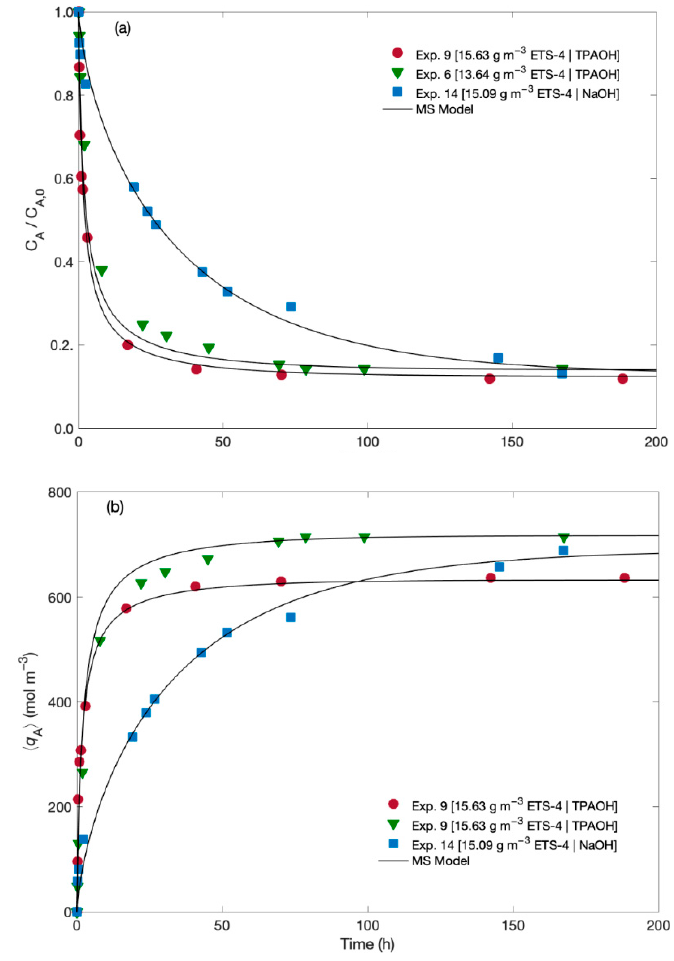
Figure 2. Experimental (symbols) and MS model (lines) results along time for ( a ) normalized Hg 2+ concentration in the fluid, and ( b ) in the solid.